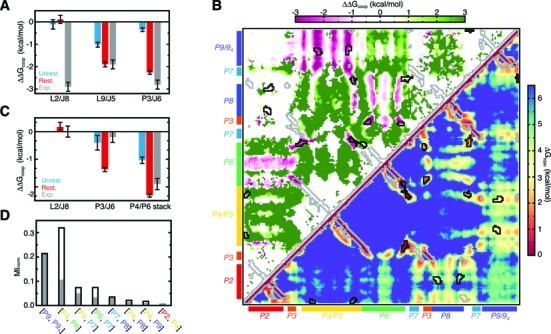
Topological constraints give rise to cooperativity between distal tertiary interactions. (A) Cooperativity between the TH and indicated tertiary interactions compared to values measured experimentally (27). Errors represent the standard deviation over the unrestrained main text and two SI simulations, and three replicate restrained simulations. (B) The ΔGtopo of forming pairwise tertiary contacts in the TH-restrained Azoarcus ribozyme (lower triangle), and the ΔΔGcoop computed relative to the unrestrained simulation (upper triangle). Regions outlined in black correspond to bona fide long-range tertiary interactions. Regions that are proximal in the native structure but do not interact are outlined in gray. (C) Cooperativity between L9/J5 and the indicated tertiary interactions, compared to values measured experimentally (27). A lack of sampling precluded computation of ΔΔGcoop between L9/J5 and L2/J8 from the unrestrained simulations. (D) The MInorm between the (αh, βh, γh) distributions of selected helices computed relative to P3 for the TH-restrained (open black bars) and unrestrained (filled gray bars) simulations. To normalize for differences in simulation length, MInorm values for the unrestrained simulation were computed using only the first 109 simulation steps.